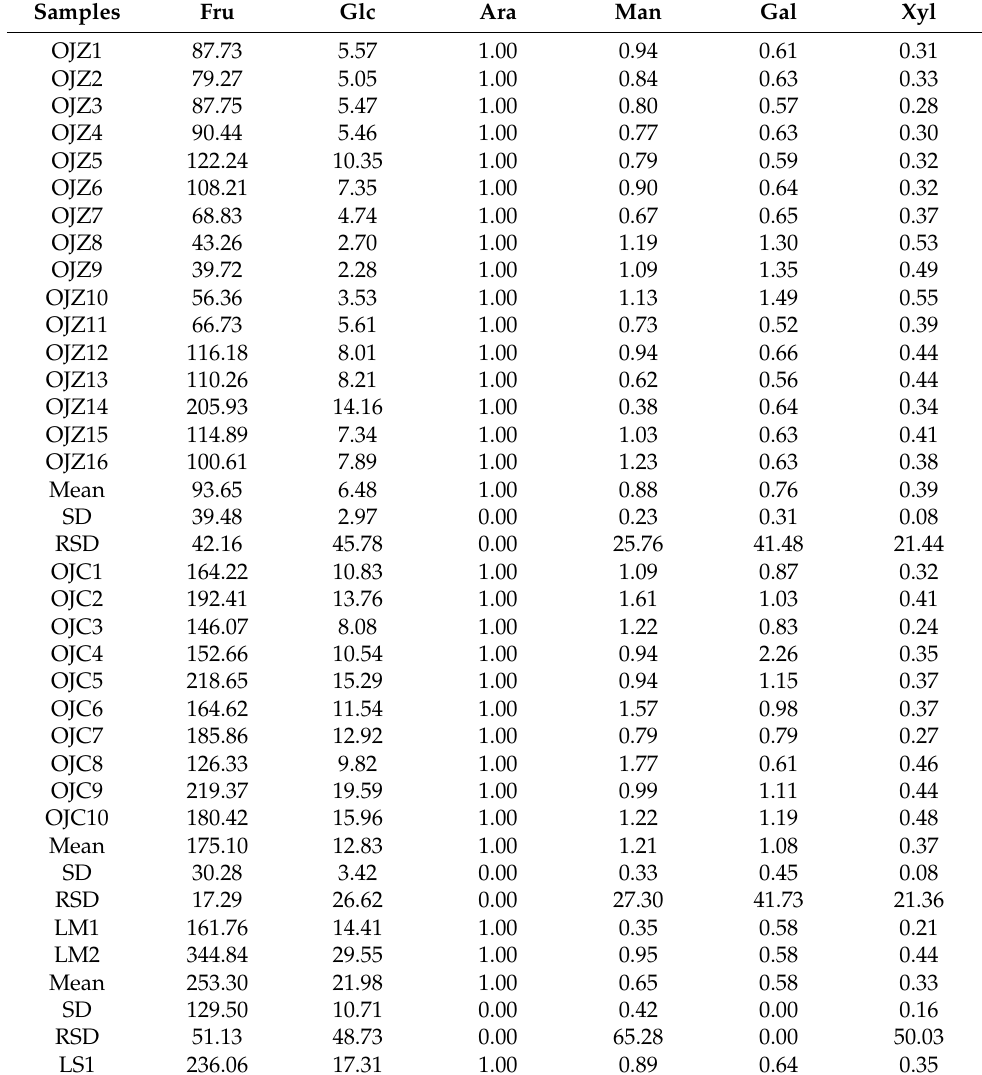
Table 3. Molar ratio of compositional monosaccharides of OJZP, OJCP, LMP, and